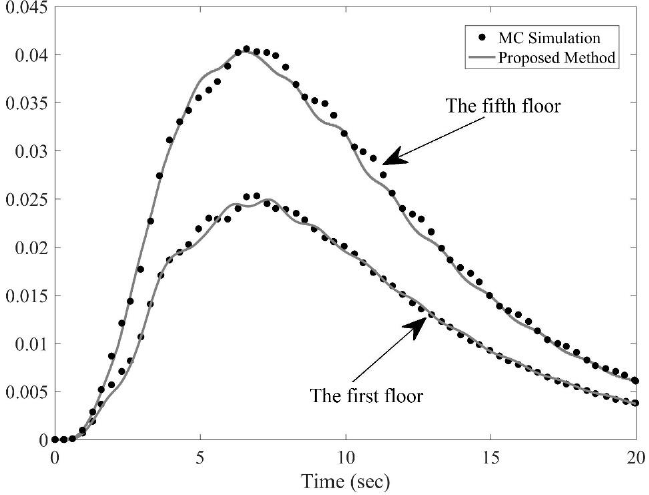
Figure 14. Mean square displacement response of a 5DOF Duffing–Van der Pol system under nonstationary excitation. ( γ = 1.0, μ = 1.0).